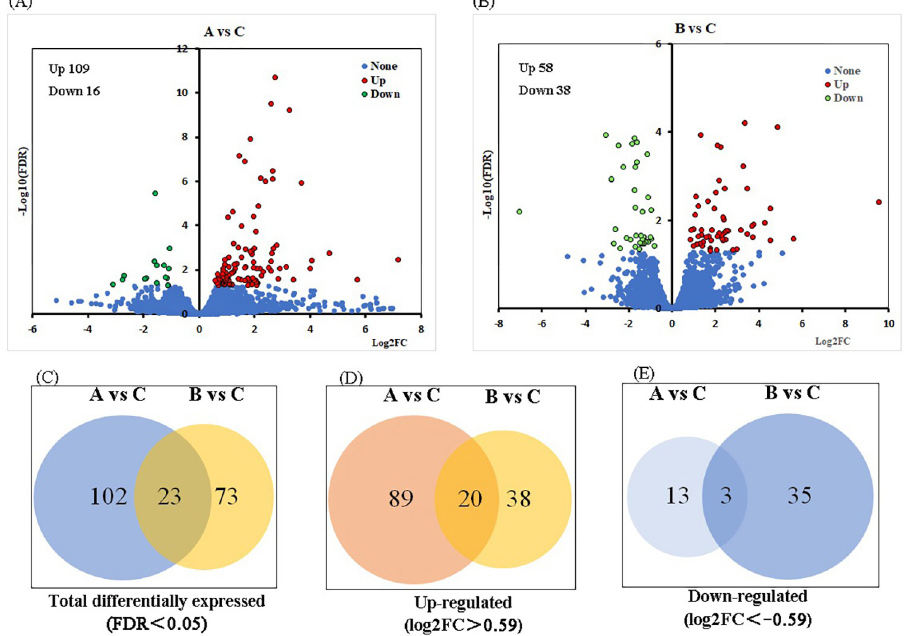
Fig 1. DEGs in the skeletal muscle of Min pig after cold stress. A. Volcano plot for chronic low-temperature acclimation group (A) after cold stress. Red points represent the upregulated genes; green points represent the downregulated genes (|log 2 FC| > 0.59 and p < 0.05), and blue points represent the not significantly DEGs (p > 0.05). B. Volcano plot for acute short cold stress group (B) after cold stress. The means of color points are similar to A. C. Total DEGs in the groups A and B after cold stress. D. Upregulated DEGs in the groups A and B after cold stress. E. Downregulated DEGs in the groups A and B after cold stress.